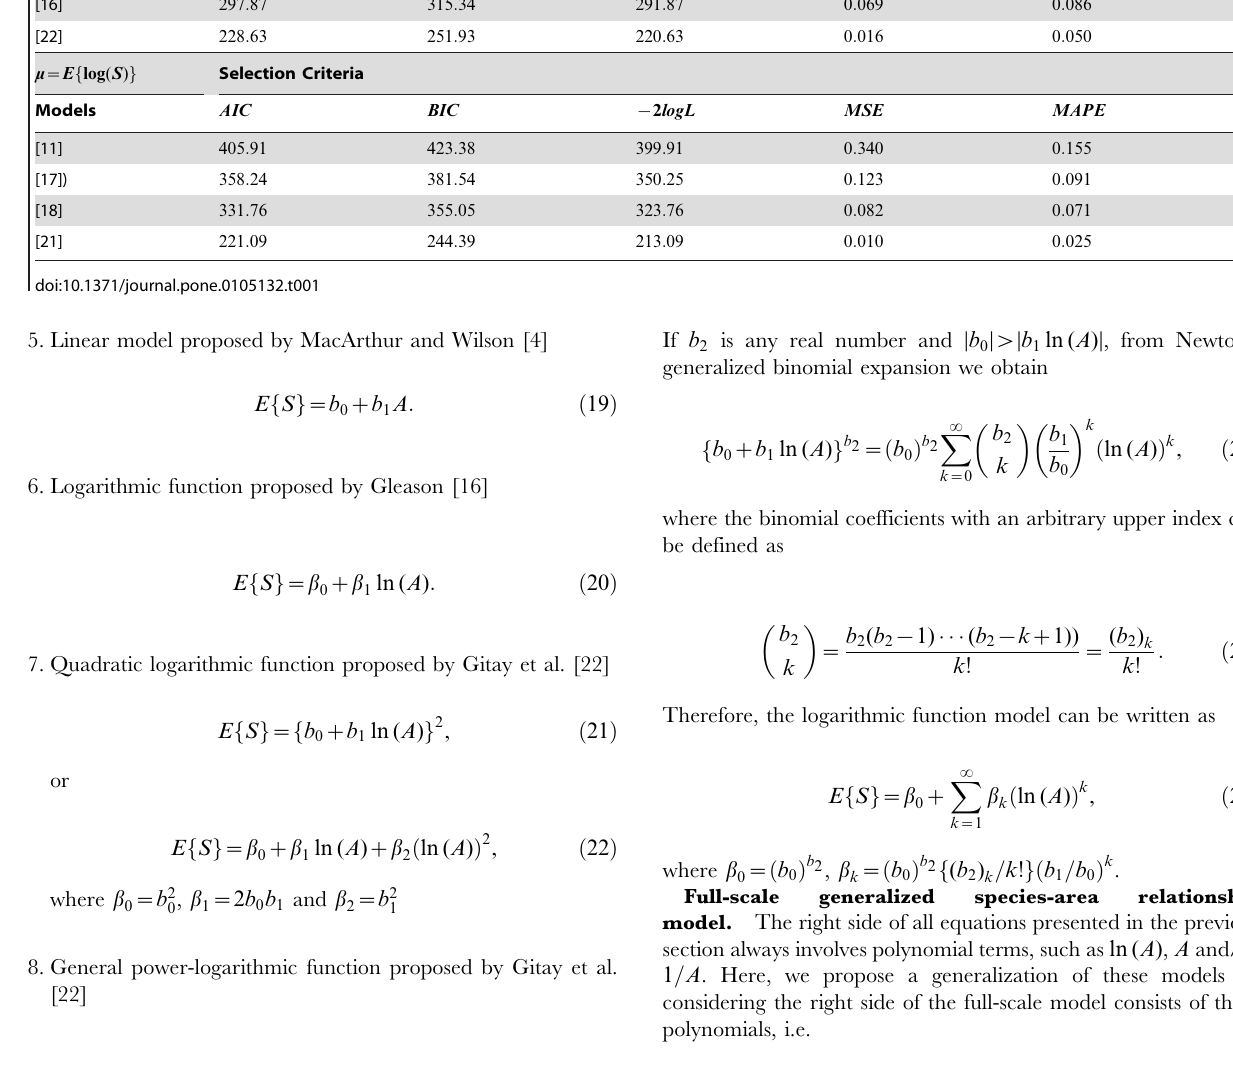
m ~ E f S g Selection Criteria Models